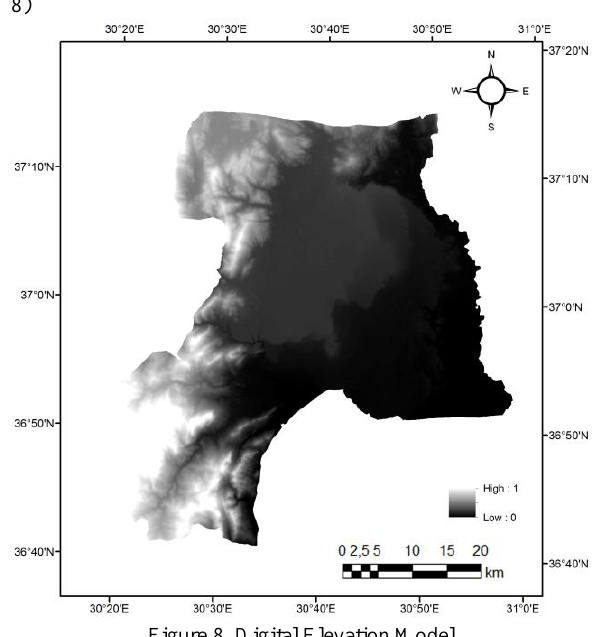
Figure 8. Digital Elevation Model